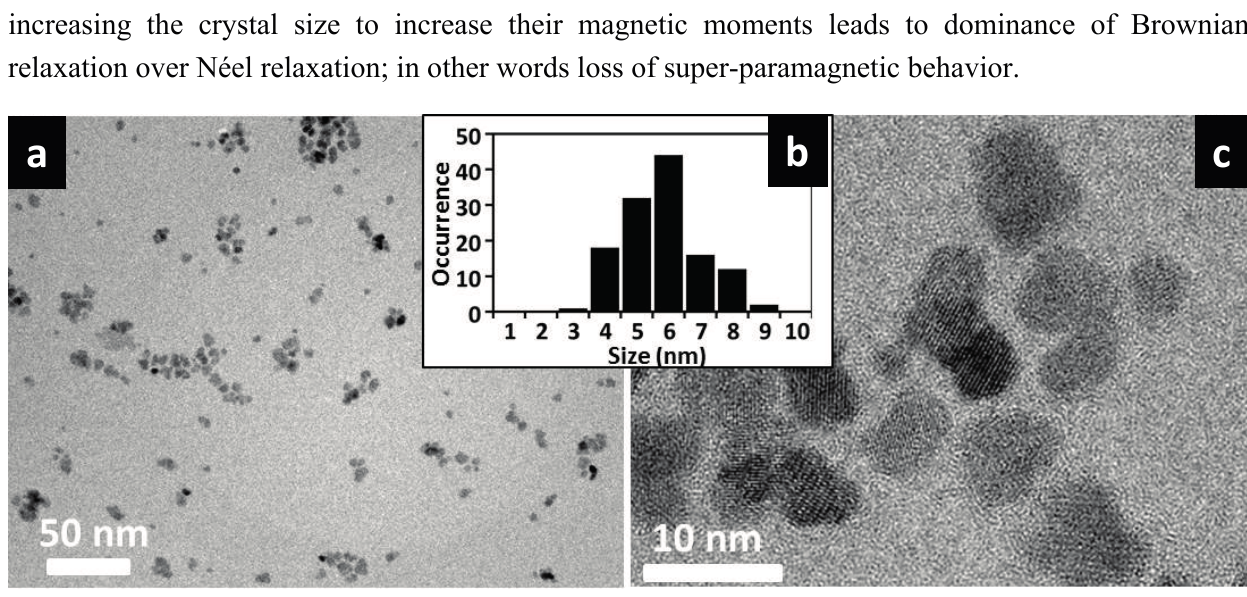
Figure 1. ( a ) Representative TEM (Transmission electron microscope) image of the SPION cores; ( b ) Size histogram generated from particle size analyses from several TEM images; ( c ) High-resolution TEM image showing well developed lattice